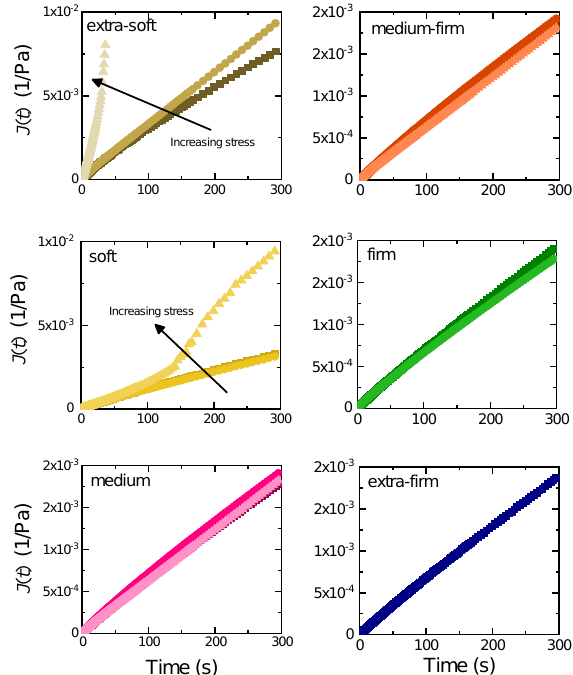
Figure 6: Creep compliance J ( t , σ 0 ) from experiments, analogous to the Figure 2 time-lapse conditions subjected to gravitational forcing, at increasing stress amplitude. σ 0 = 10 2 , 10 3 , 10 4 Pa for each polysilicone putty. For the softest putty, only the lowest stress amplitude is in the linear region. Experimental limits for maximum torque prevent some higher amplitudes for the two firmest